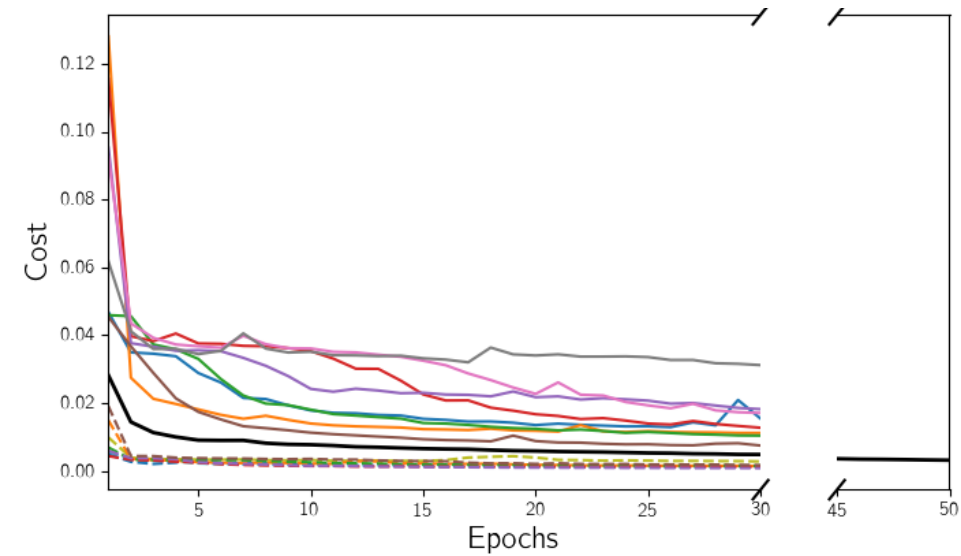
Figure 5. Cost function evolution with training epochs of all the models. Continuous lines correspond with the models using binary cross-entropy as cost function and dashed lines, with focal loss models. The black curve is the cost function of the best model, used in the evaluation in Section